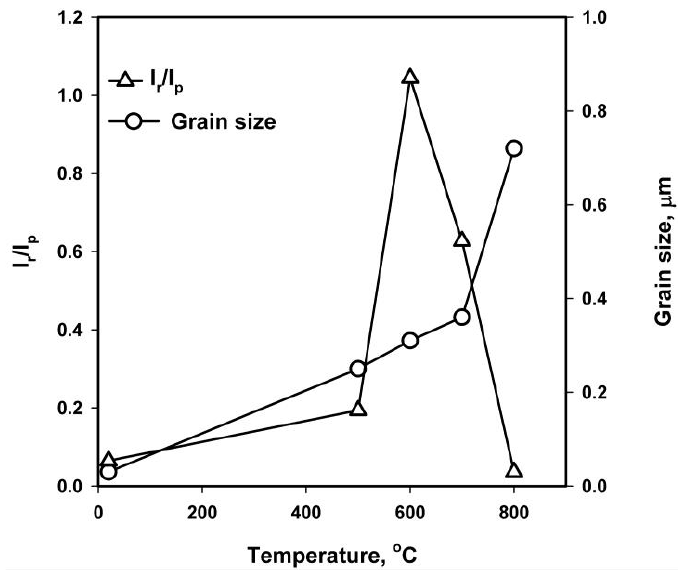
Figure 34. Effect of SPD temperature on the grain size and a ratio of reactivating/passivating current for a UFG 304-type stainless steel.